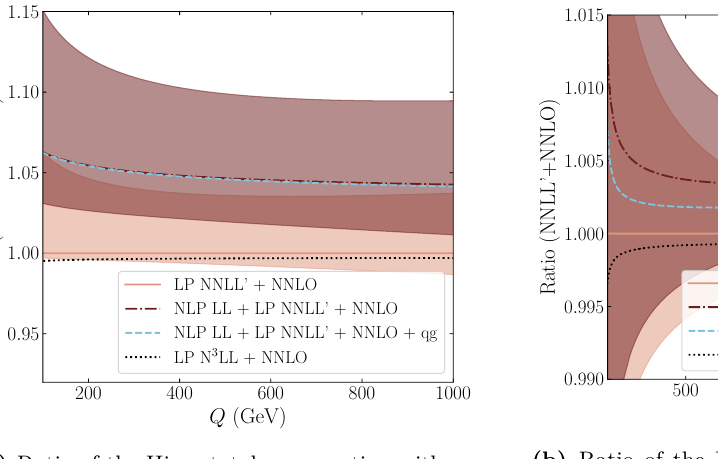
Figure 11. Ratio plot for the Higgs total cross section (left) and DY invariant mass distribution (right), normalized to the NNLL 0 + NNLO result. The NNLL 0 (+NLP LL) result is again shown by the orange solid (red dash-dotted) lines. The NNLL 0 NLP LL result obtained by adding the N 3 LO NLP LL qg result is shown by the dotted light-blue